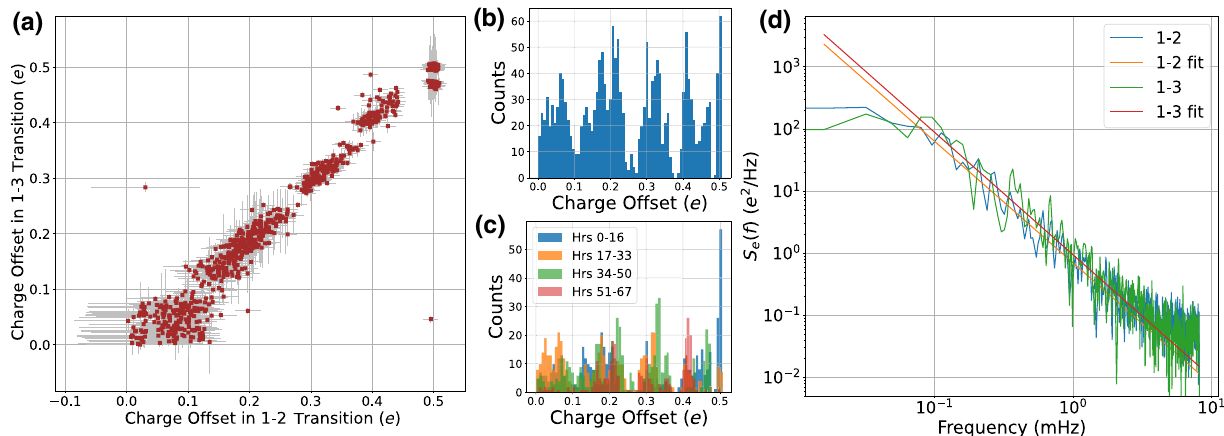
FIG. 4. Low-frequency dynamics of the qubit charge environment. (a). High-precision qubit spectroscopy measurements in the 1-2 and 1-3 transitions are taken interwoven with each other over the course of 70 h. Displayed are ordered pairs of the offset charge extracted from adjacent measurements of the 1-2 and 1-3 transitions showing a clear correlation between the two data sets. Note the data is presented in units of 1 e in this figure. (b). The charge offsets form a highly nonuniform distribution. (c). The same data displayed above in (b) is binned such that the different colors in the histogram correspond to each 17 h of data. The similarity between the different time bins suggests the charge environment prefers certain discrete configurations as opposed to simply not having the opportunity to fully explore its configuration space in the measurements time. (d) The power spectral density of the charge-offset dynamics at base temperature shows an 1 / f α noise with α = 1.94 and magnitude at 1 Hz of 1.11 × 10 − 6 e 2 /